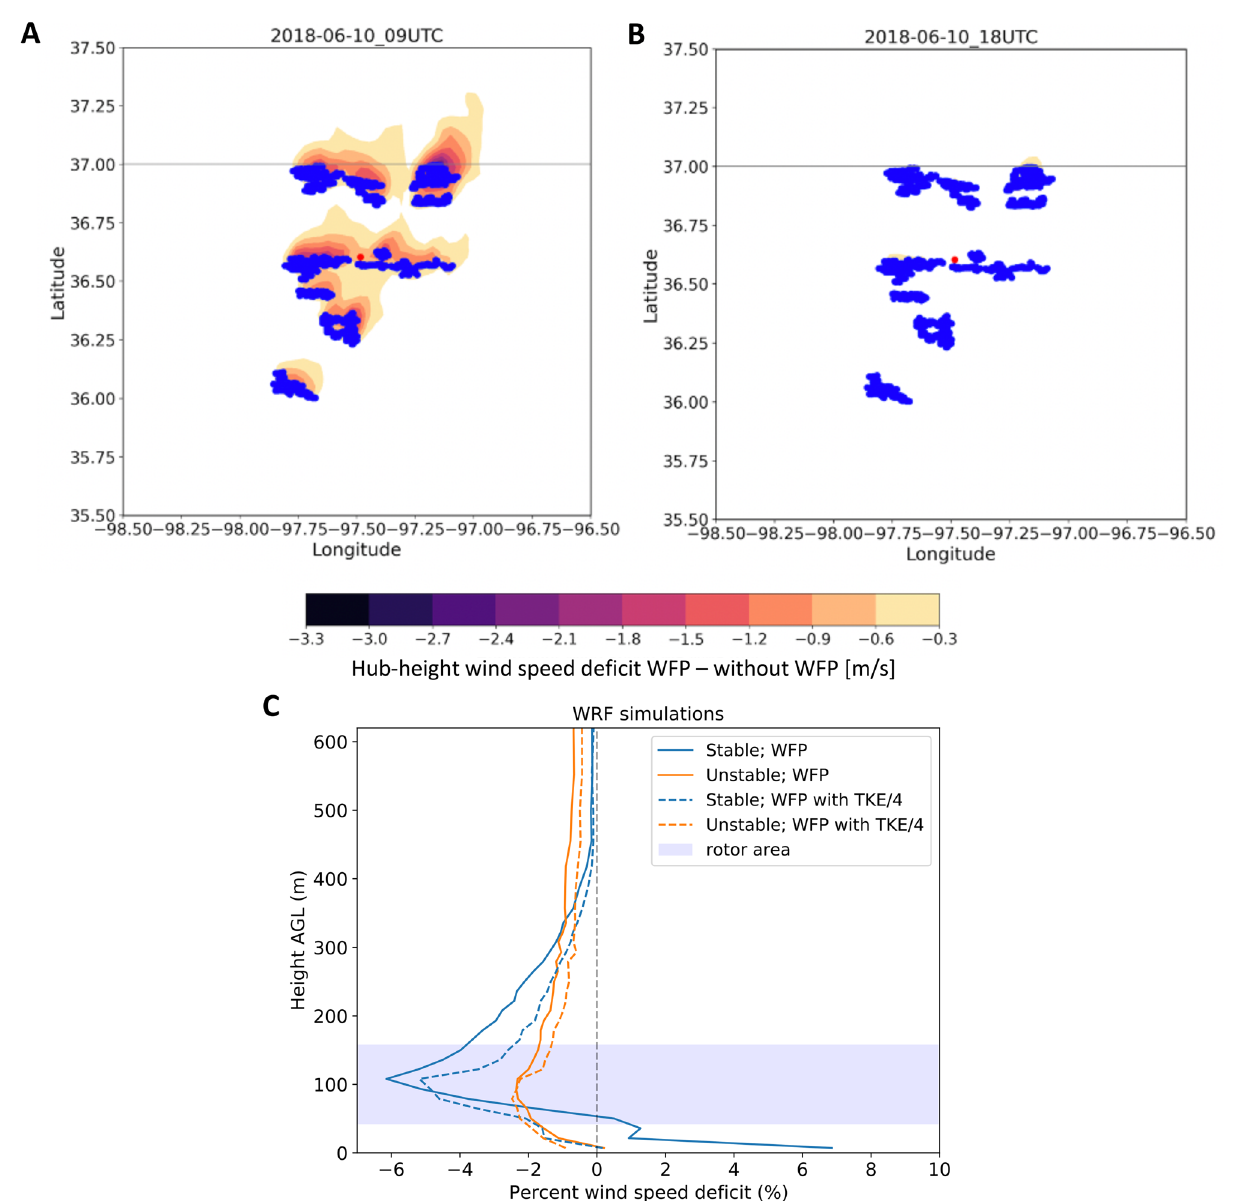
Figure 3. ( A , B ) Contours of hub-height wind speed deficit calculated by subtracting the simulation without the WFP from the WFP simulation at two sample times on June 10: ( A ) 0900 UTC (0300 LT); ( B ) 1800 UTC (1200 LT); blue dots represent wind turbines. ( c ) Median profile of WRF-simulated percentage wind speed deficit (calculated as either (WFP − without WFP)/(without WFP) or (WFP25 − without WFP)/(without WFP)) at the C1 location for stable (negative surface heat flux) and unstable (positive surface heat flux) conditions for wind directions between 112 ◦ and 196 ◦